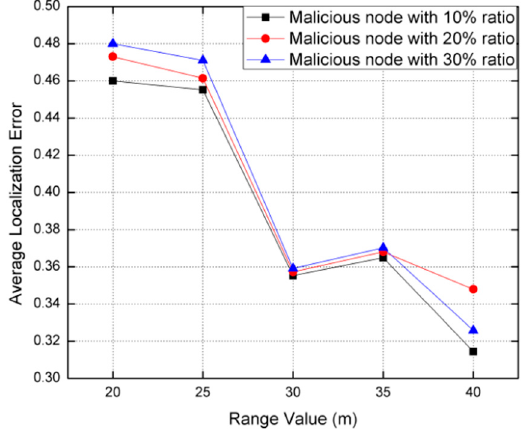
Figure 7. Error variation with the range according to malicious node ratio. Table 4. Average localization error under the impact of malicious nodes corresponding to the range.